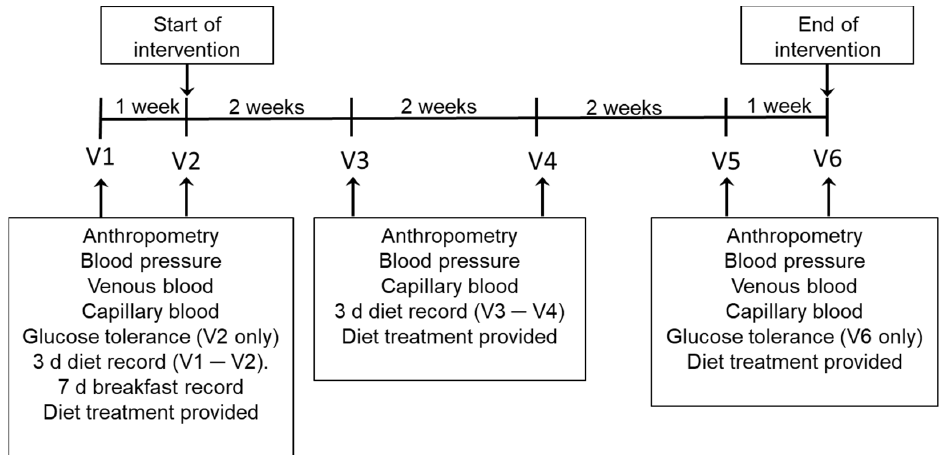
Figure 1. Timeline of the study showing the timing of blood sampling and dietary recording at each clinic visit (V).